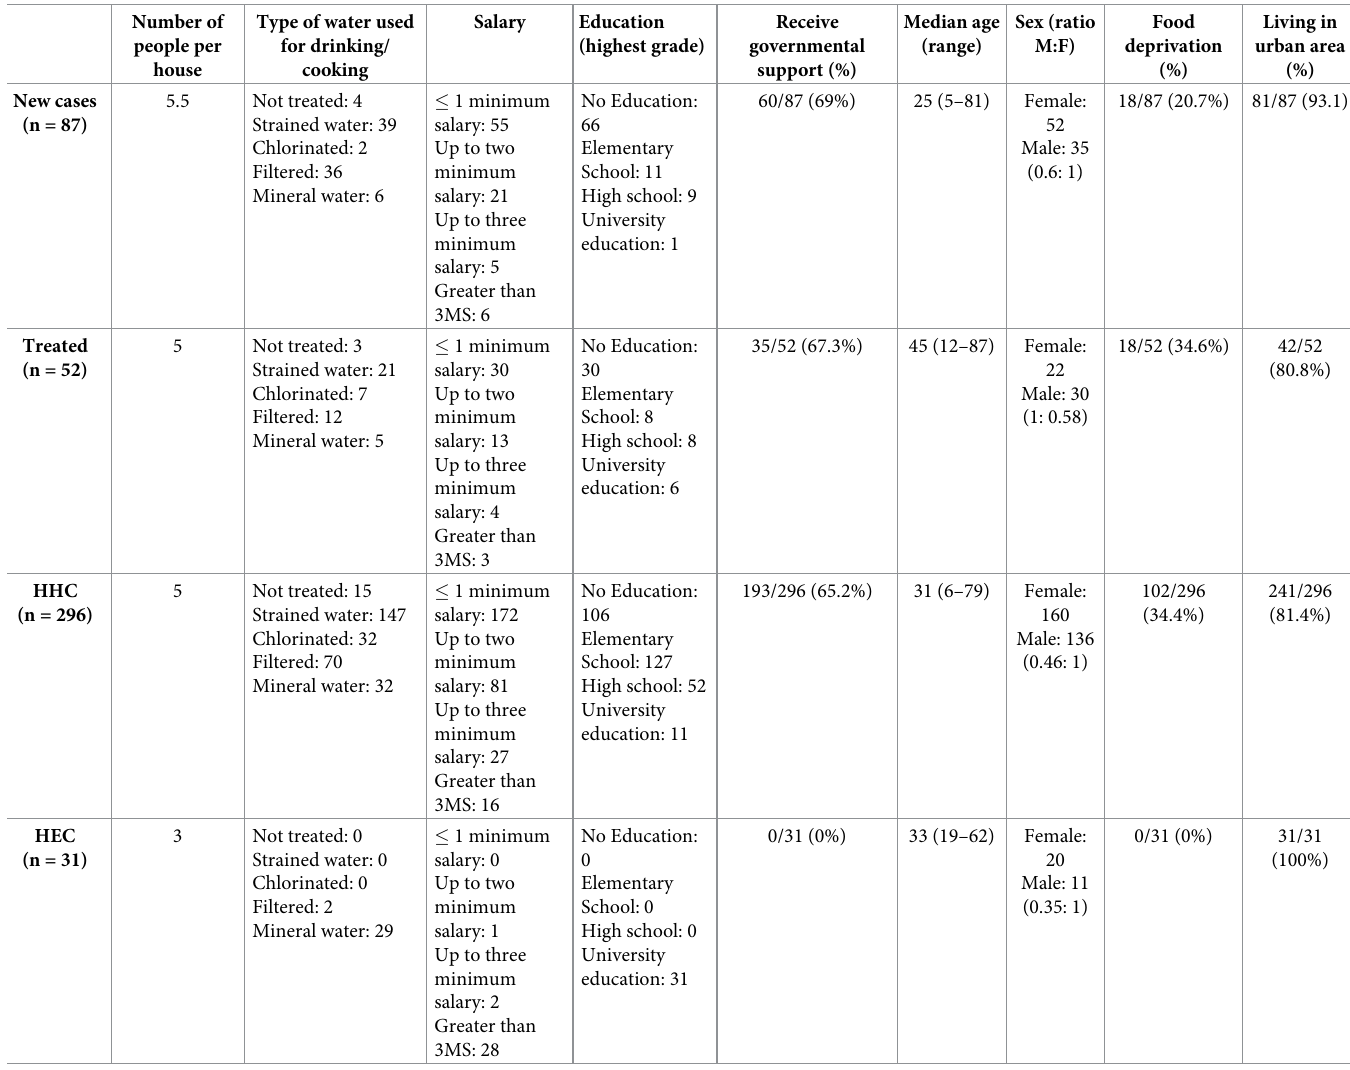
Table 3. Demographic information of the four groups studied (new leprosy cases, treated patients, HHC and HEC) including household density (average number of people living in the house), type of water used for drinking and cooking, income level, education level, receiving governmental support, median age and range, ratio of number of males to females, incidence of food deprivation and living in an urban versus a rural area. Number of people